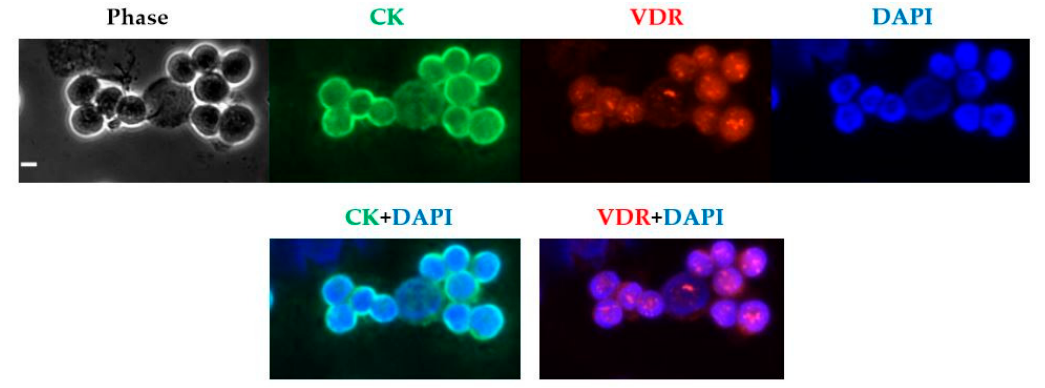
Figure 2. VDR expression detection in MCF-7 cells. Fluorescence labeling of VDR (in red) and CK (in green) with DAPI (in blue) nuclear staining was performed on 10 6 MCF-7 cells. Original magnification, ×40. Scale bar (white bar in the upper left image), 10 μ m. DAPI: 4 ′ -6-Diamidino-2- Phenylindole.